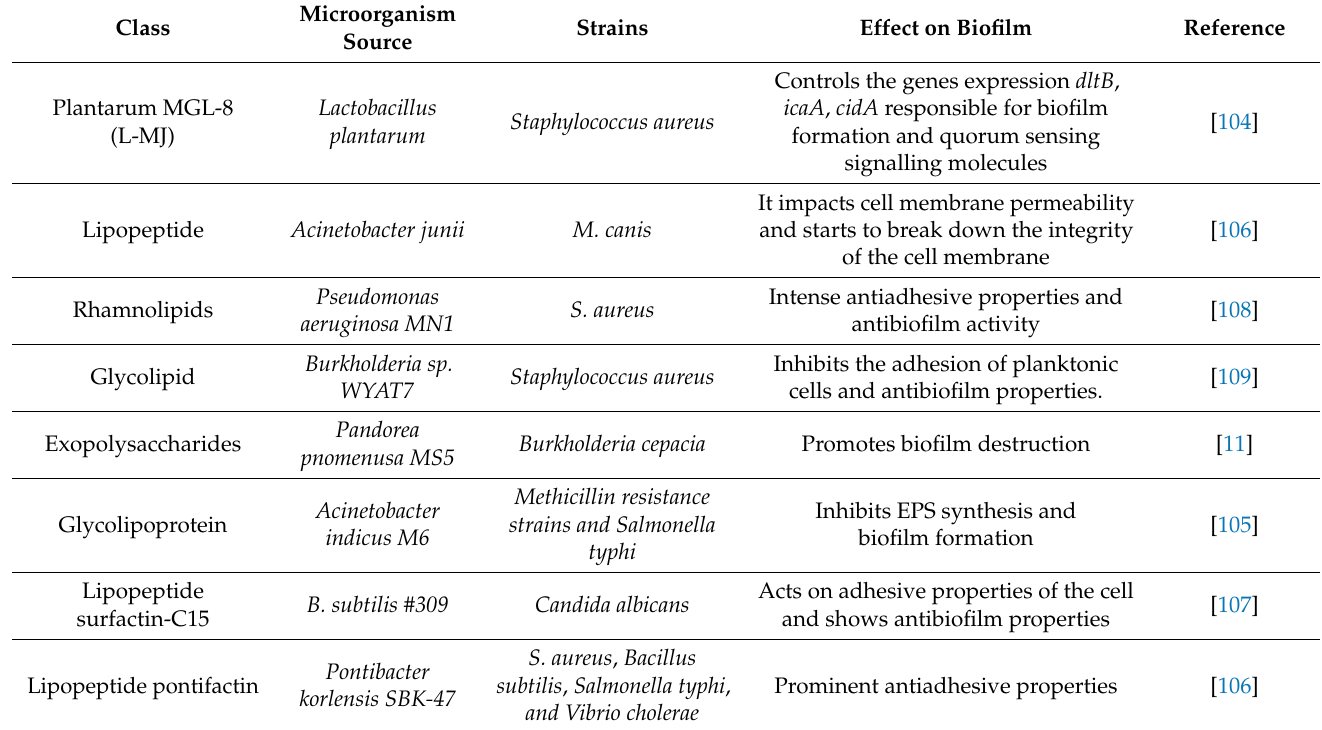
Table 2. List of biosurfactants with their effect on biofilm